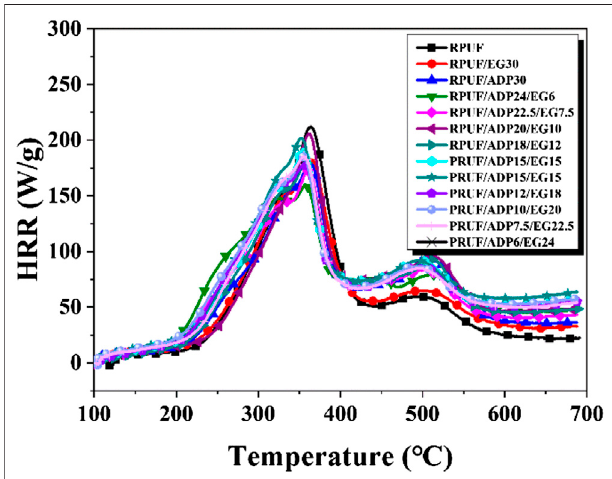
FIGURE 3 | MCC results of RPUF and FR-RPUF composites.